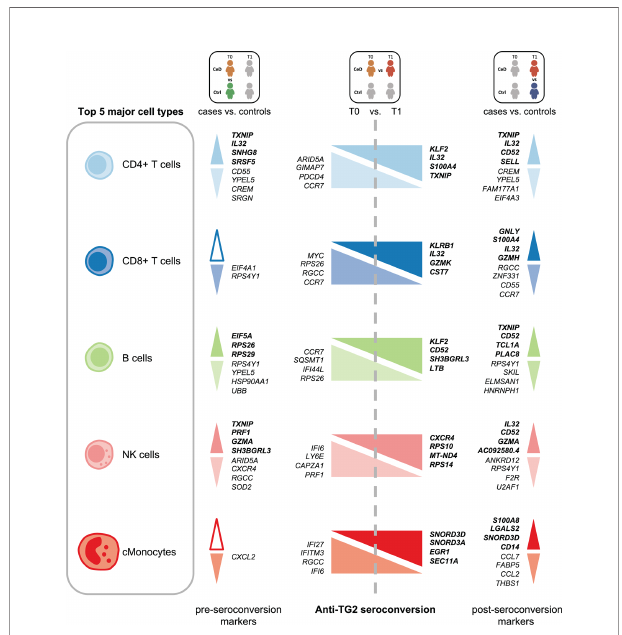
FIGURE 3 | Top DEGs per cell type. Diagram of the top 4 DEGs (FDR < 0.05, absolute log2FC > 0.25) with the highest absolute log2FC value per cell type for the comparisons: CeD cases T0 vs. controls T0, CeD cases T0 vs. T1 and CeD cases T1 vs. controls T1. The top 5 most abundant cell types are depicted. Colors correspond to different cell-types. The upregulated genes are shown in bold font, whereas downregulated genes are in normal font. Color intensities of arrows indicate the direction of differential expression, where dark colors are for upregulation, light colors are for downregulation and white is used when no DEGs was found on that speci fi c